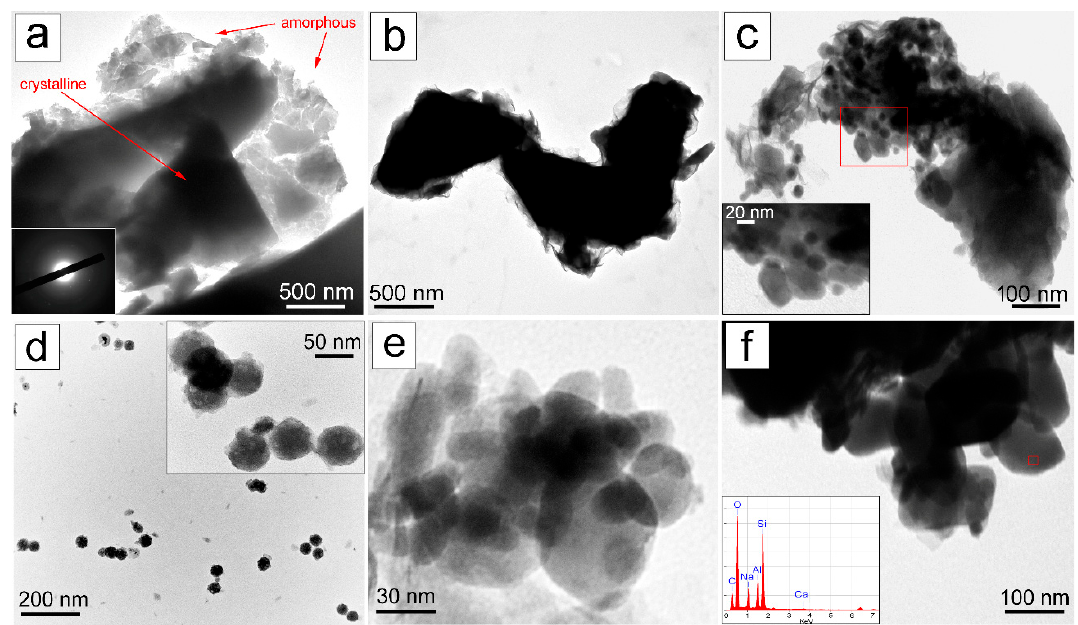
Figure 6. TEM micrograph of ( a ) ash Et, the inset shows the corresponding ring-shaped selected-area electron diffraction (SAED) pattern of the amorphous fragment; ( b ) run Et1; ( c ) analcime crystal (run Et3), magnification of the empty red rectangle showing aspheric analcime crystals; ( d ) analcime crystals (run Et4,) magnification of the empty black rectangle showing aspheric analcime crystals; ( e ) analcime crystals (run Et 5); ( f ) analcime crystals (run Et 6) with the relative EDS point analysis.